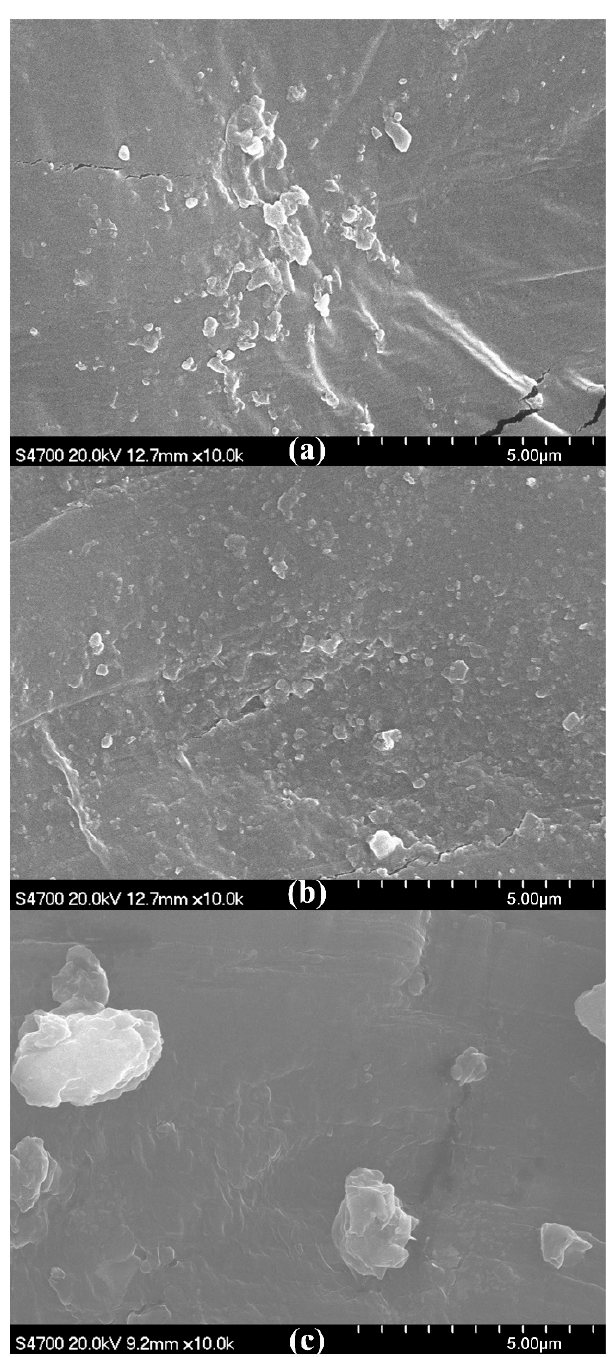
Figure 7. SEM micrographs of fracture surfaces of OMMT-modified UHMWPE pipes. ( a ) w HDPE-g-MAH Figure7. SEMmicrographsoffracturesurfacesofOMMT-modifiedUHMWPEpipes. ( a ) w HDPE-g-MAH = = 1%, ( b ) w HDPE-g-MAH = 3%, ( c ) w HDPE-g-MAH = 5%. 1%, ( b ) w HDPE-g-MAH = 3%, ( c ) w HDPE-g-MAH =